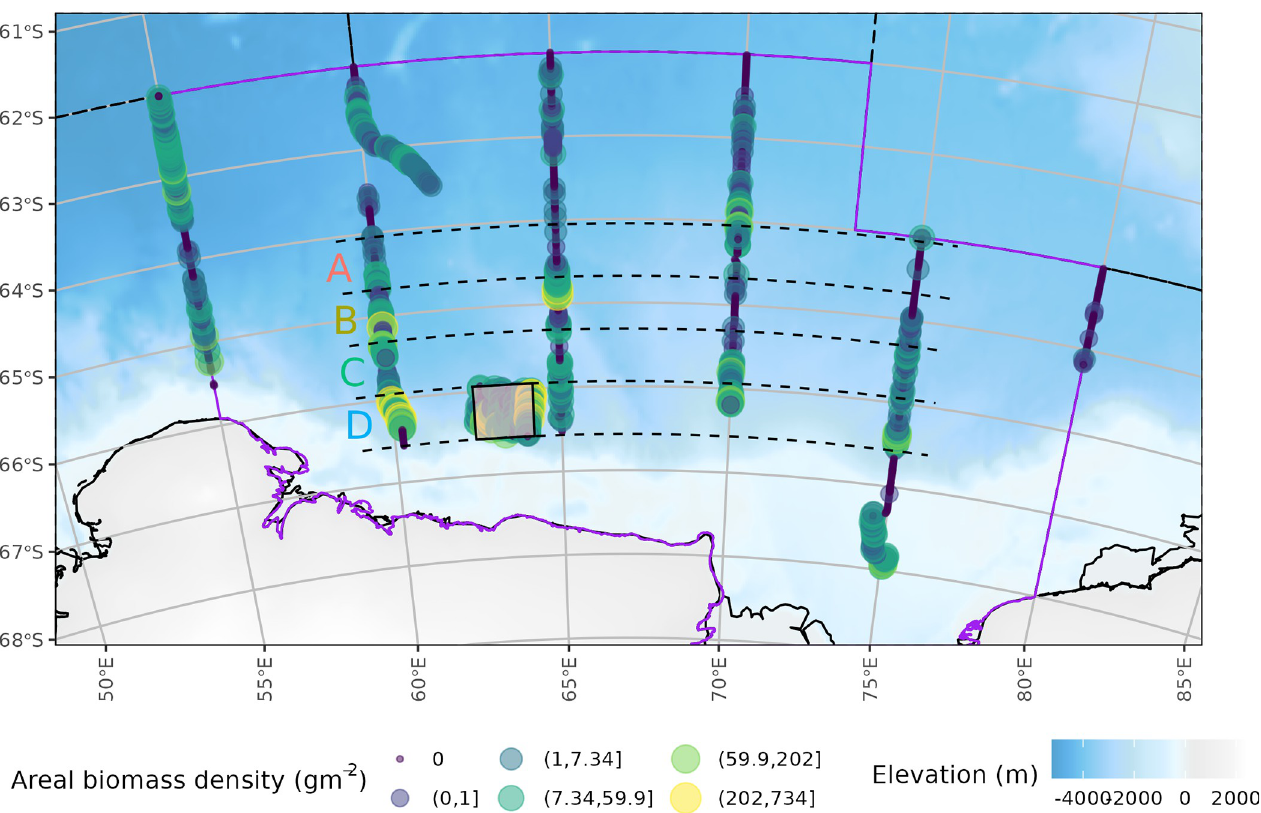
Fig 10. Variation in krill density with latitude. The main-survey transects were divided into four latitudinal bands (black dashed lines; labelled A to D). Latitudinal band width was 0.63˚ which is equal to the latitudinal width of the Mawson box (shaded rectangle) located in latitudinal band D. NB latitudinal band letters are coloured coded to match Fig 11. The background bathymetry grid is from The GEBCO_2014 Grid, version 20150318,